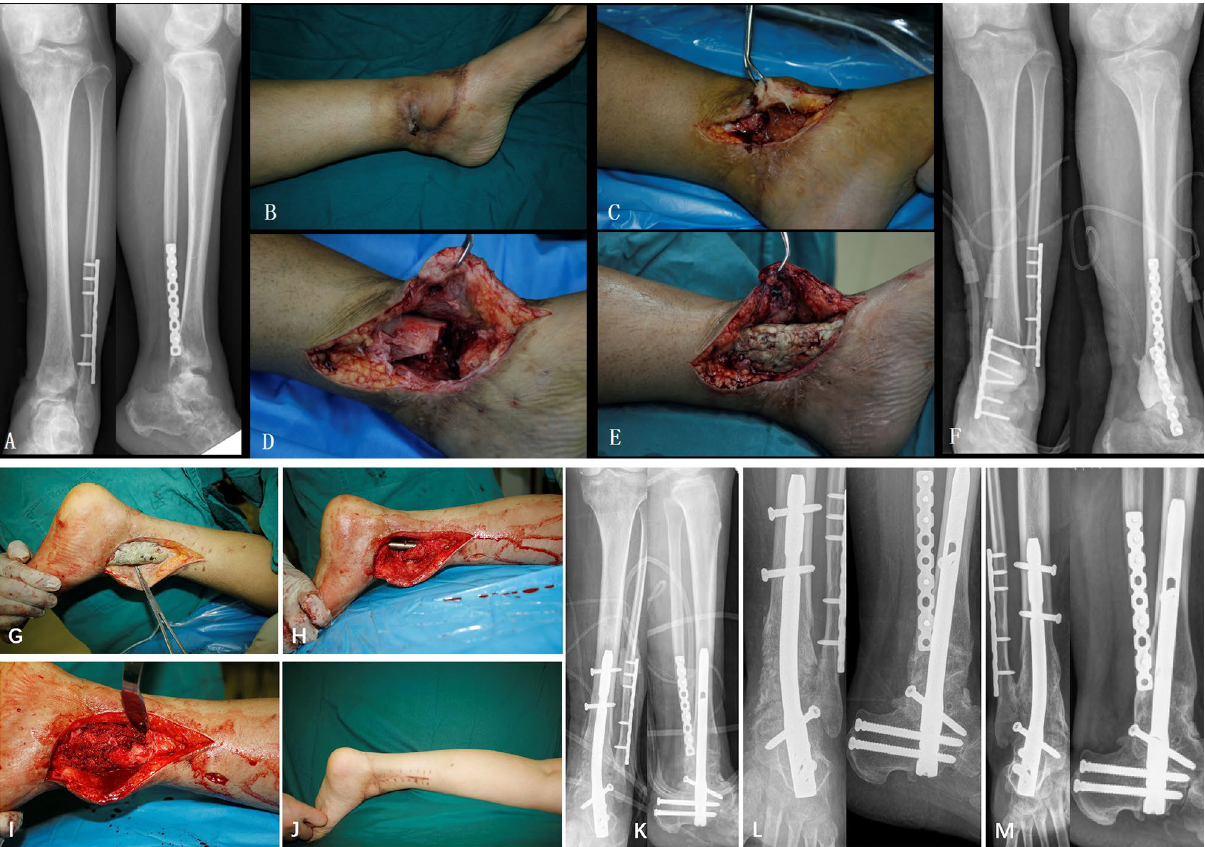
Figure 2. A 29-year-old female presented with repeated skin ulceration and pus of the left leg for 8 months. ( A ) Preoperative X-ray; ( B ) preoperative photograph; ( C ) pustules and necrotic tissue; ( D ) bone defects after debridement; ( E ) plate fixation and cement implantation; ( F ) postoperative X-ray; ( G ) pregrafting photograph showing no necrotic tissue; ( H ) retrograde intramedullary nail for ankle fusion; I : bone grafting; J: no ulceration or pus at the 3-month follow-up; ( K ) postoperative X-ray; ( L ) X-ray showing bone union occurring 6 months later; ( M ) bone union after 24